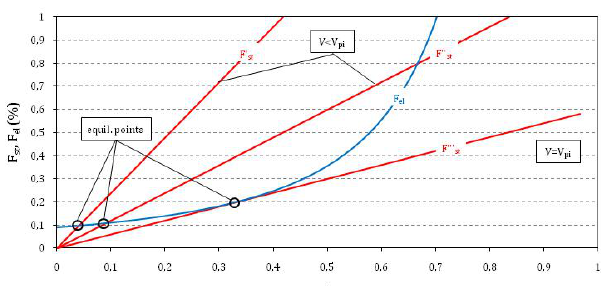
Figure 7: Relation between structural elastic force and electrostatic force; the stiffness variation causes different values of pull-in